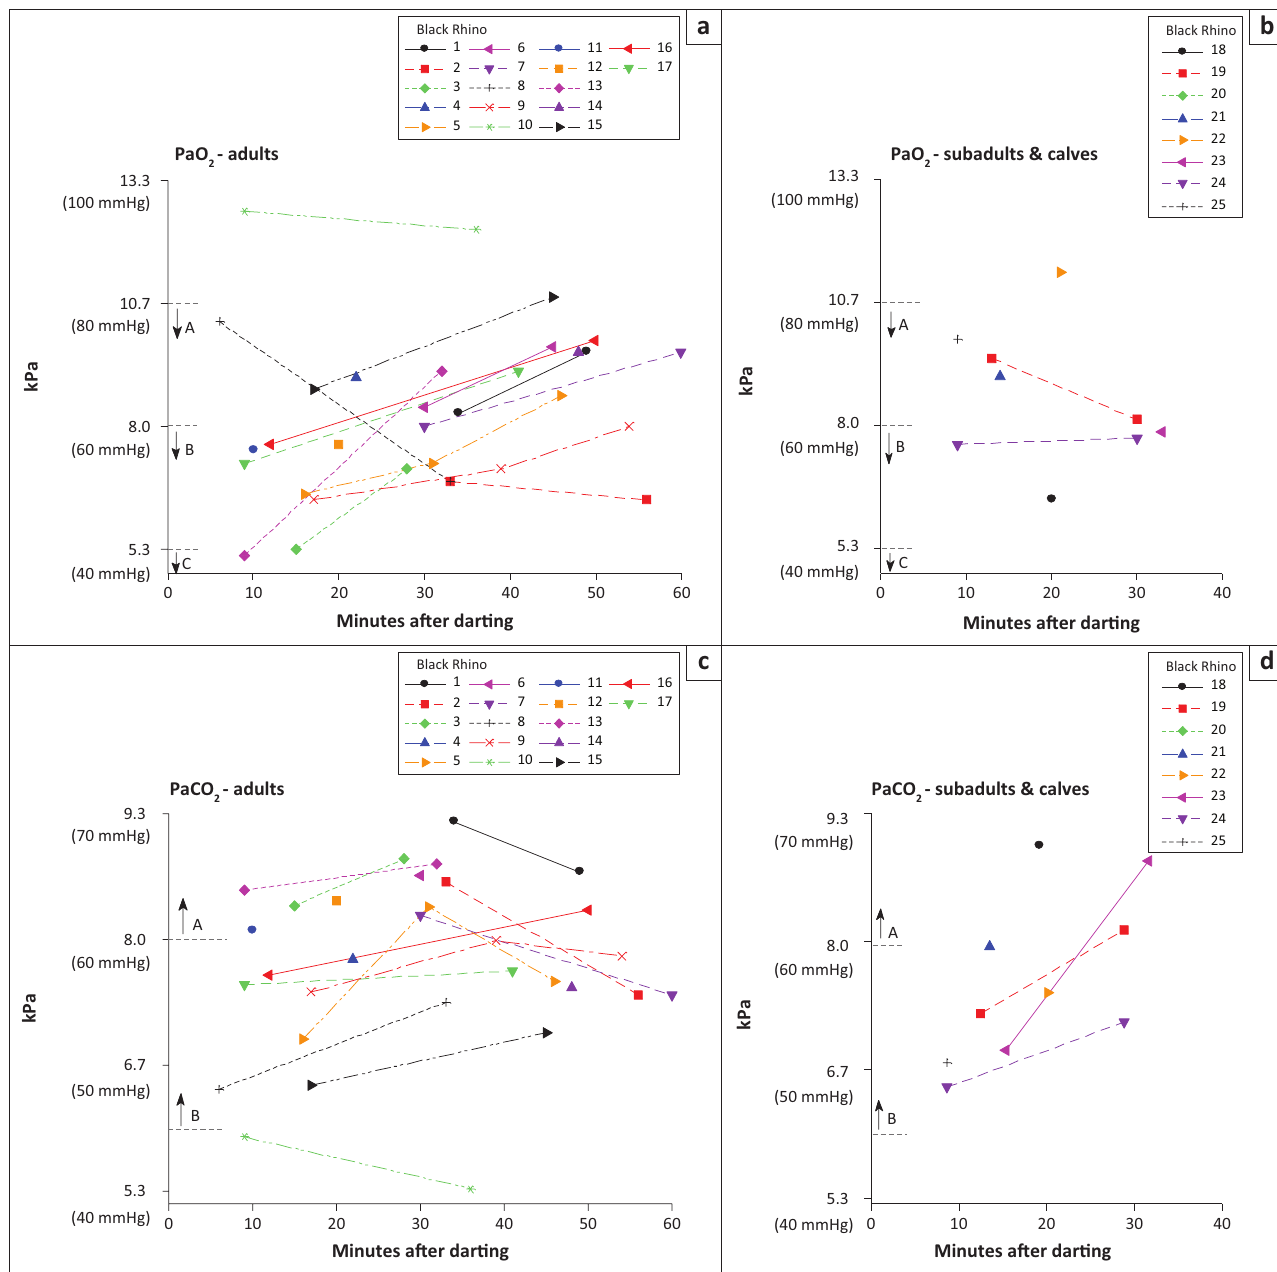
FIGURE 1: (a – h), Arterial blood gases, pH and lactate concentration in 25 free-ranging black rhinoceroses immobilised with a combination of an opioid (thiafentanil in adult #3 and subadult #18, etorphine in the others), azaperone and an α